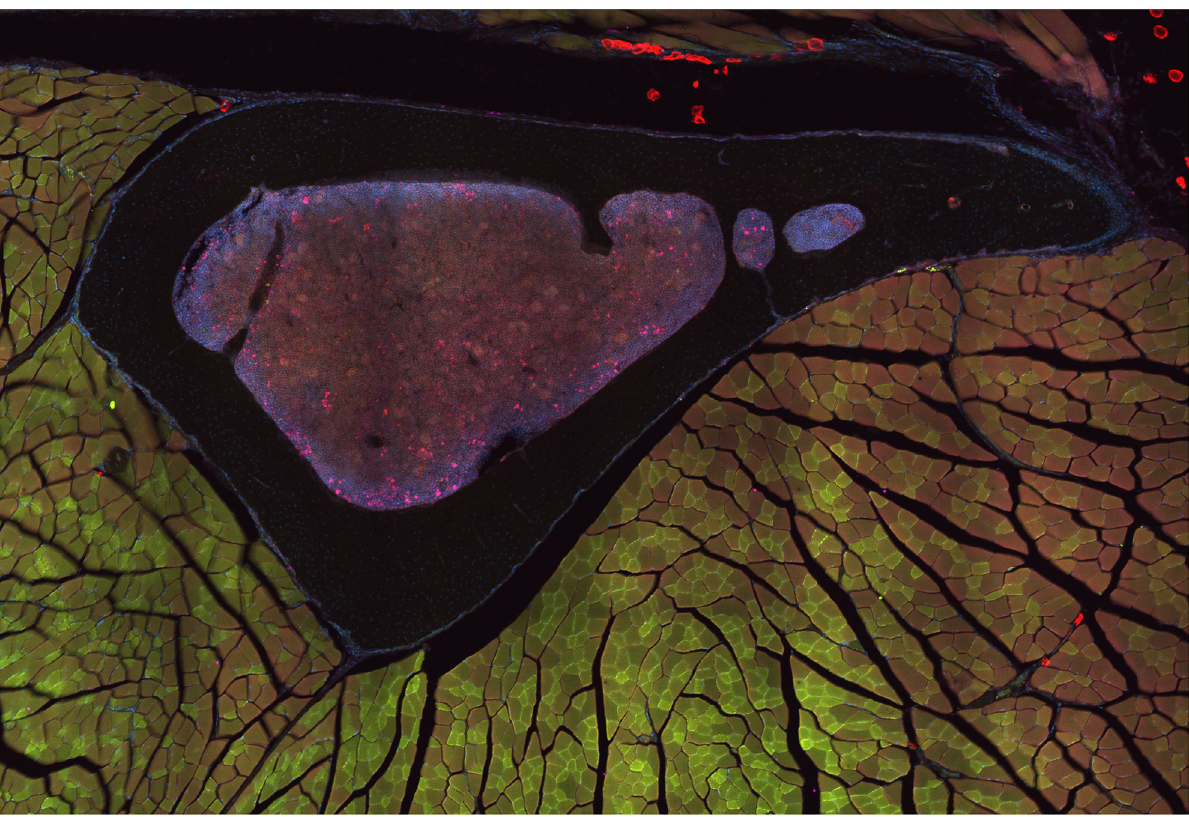
Fig 2. The four-channel tibia bone [BL6-SEC5] of mice [27] (Perilipin 1 (visualized in red), Tyrosine Hydroxylase (visualized in green), DAPI (visualized in blue), calcitonin gene-related peptite (visualized in pink)).